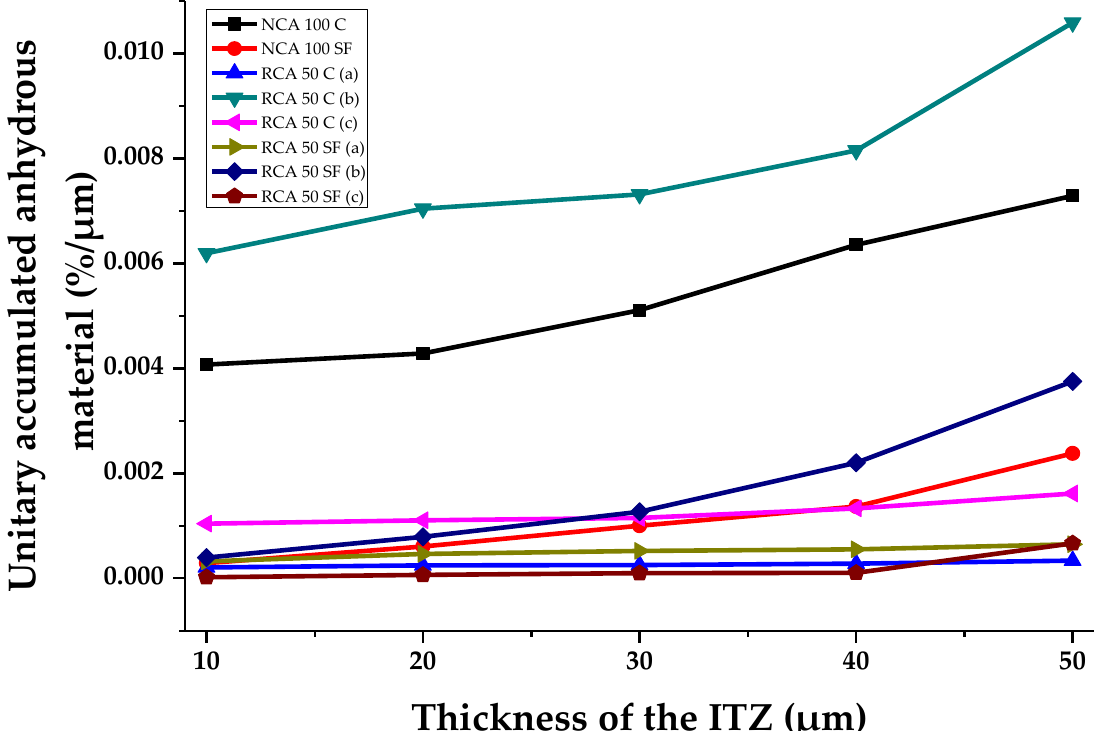
Figure 12. Anhydrous material of the samples analyzed in the IZT with various theoretical thicknesses.